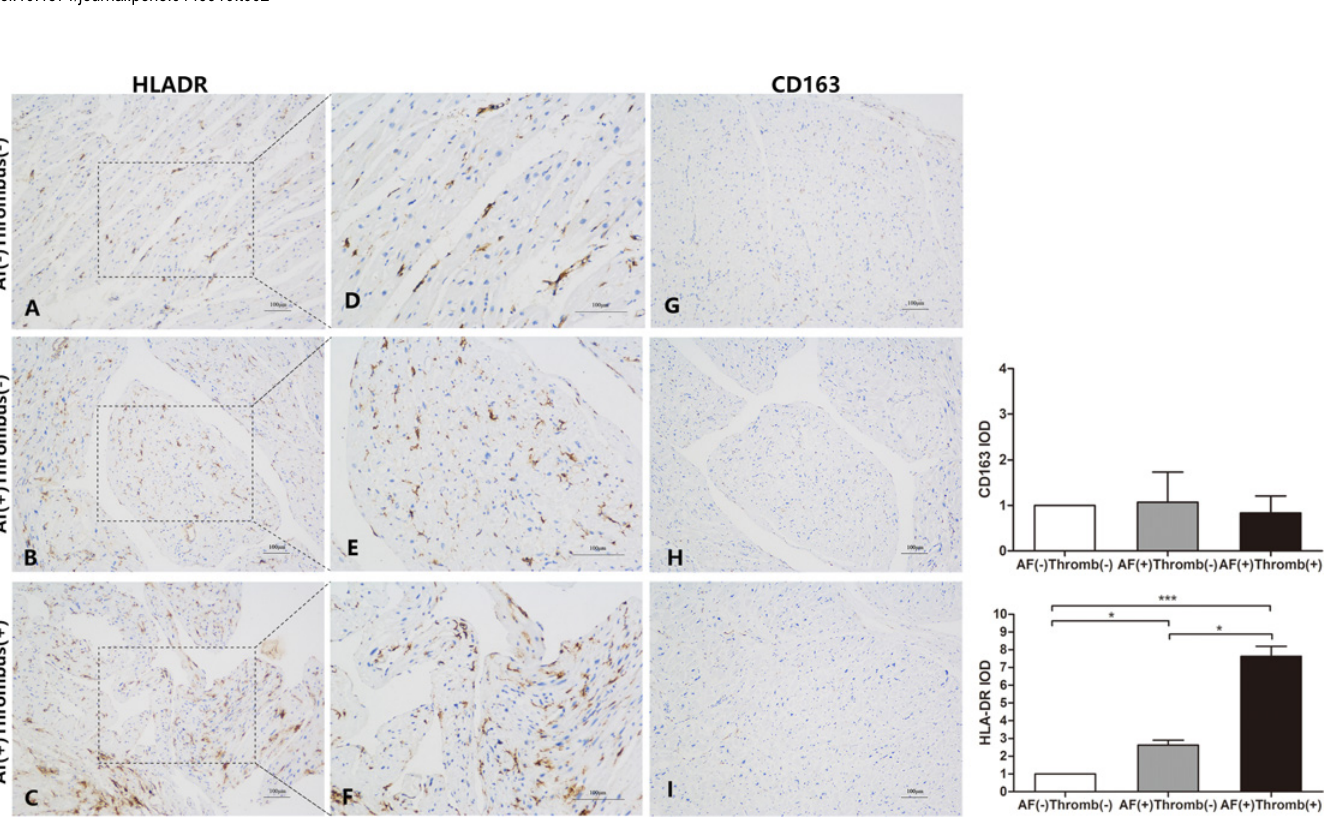
Fig 1. Immunostaining of monoclonal antibodies with anti-HLA-DR for M1 and anti-CD163 for M2 cells. (A-F) M1 cells were predominantly increased and localized in the atrial endothelium of patients with thrombus formation. (G-I) M2 cells were similar in all the three